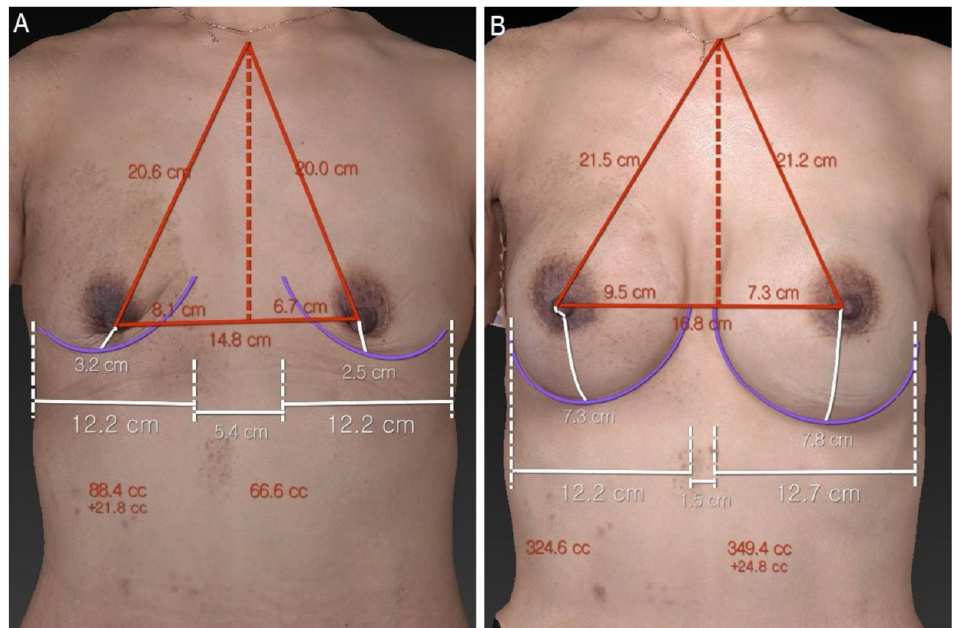
Figure 2. Three-dimensional image of the VECTRA Breast sculptor (Canfield Sci, Parsippany, NJ, USA). Evaluation with anatomical landmarks was performed on bilateral breasts. ( A ) Preoperative 3D image and ( B ) 11 months postoperative 3D image. The volume difference between the right breast (324.6 mL) and the left breast (349.4 mL) was 24.8